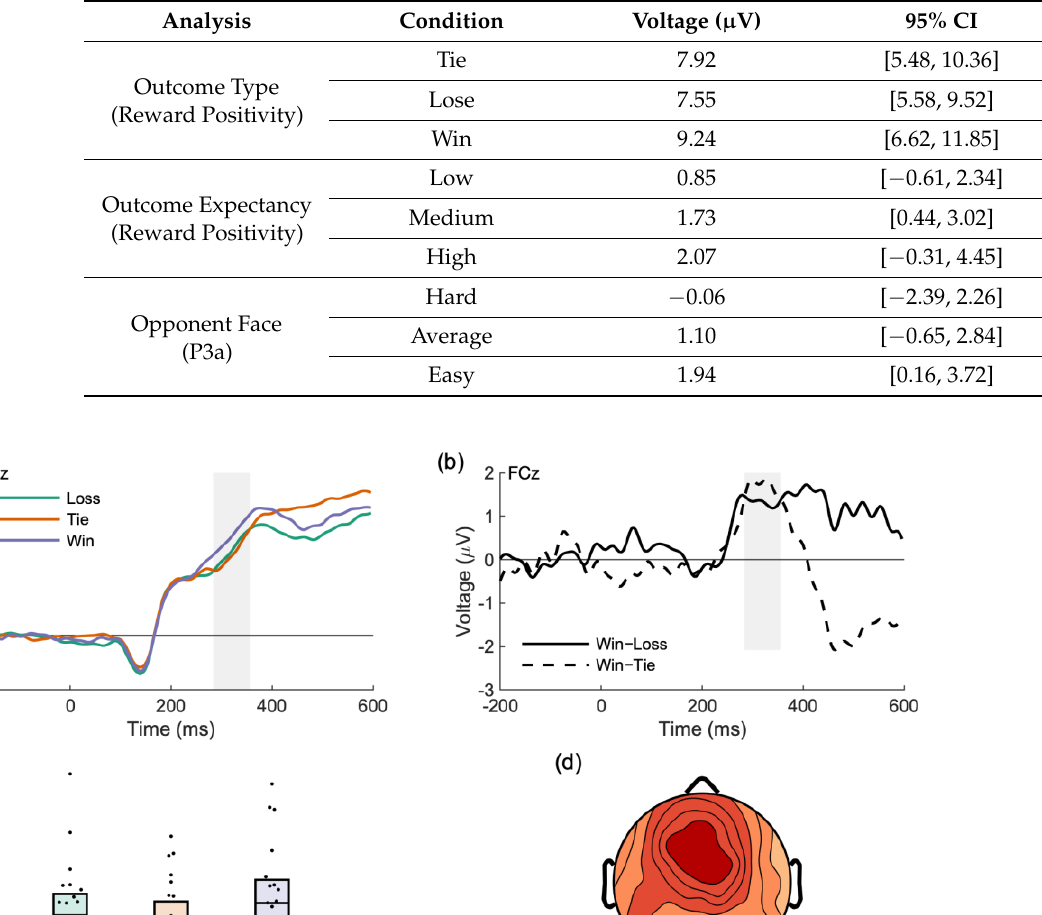
Table 1. Mean Reward Positivity and P3a for each ERP analysis, with 95% confidence intervals.